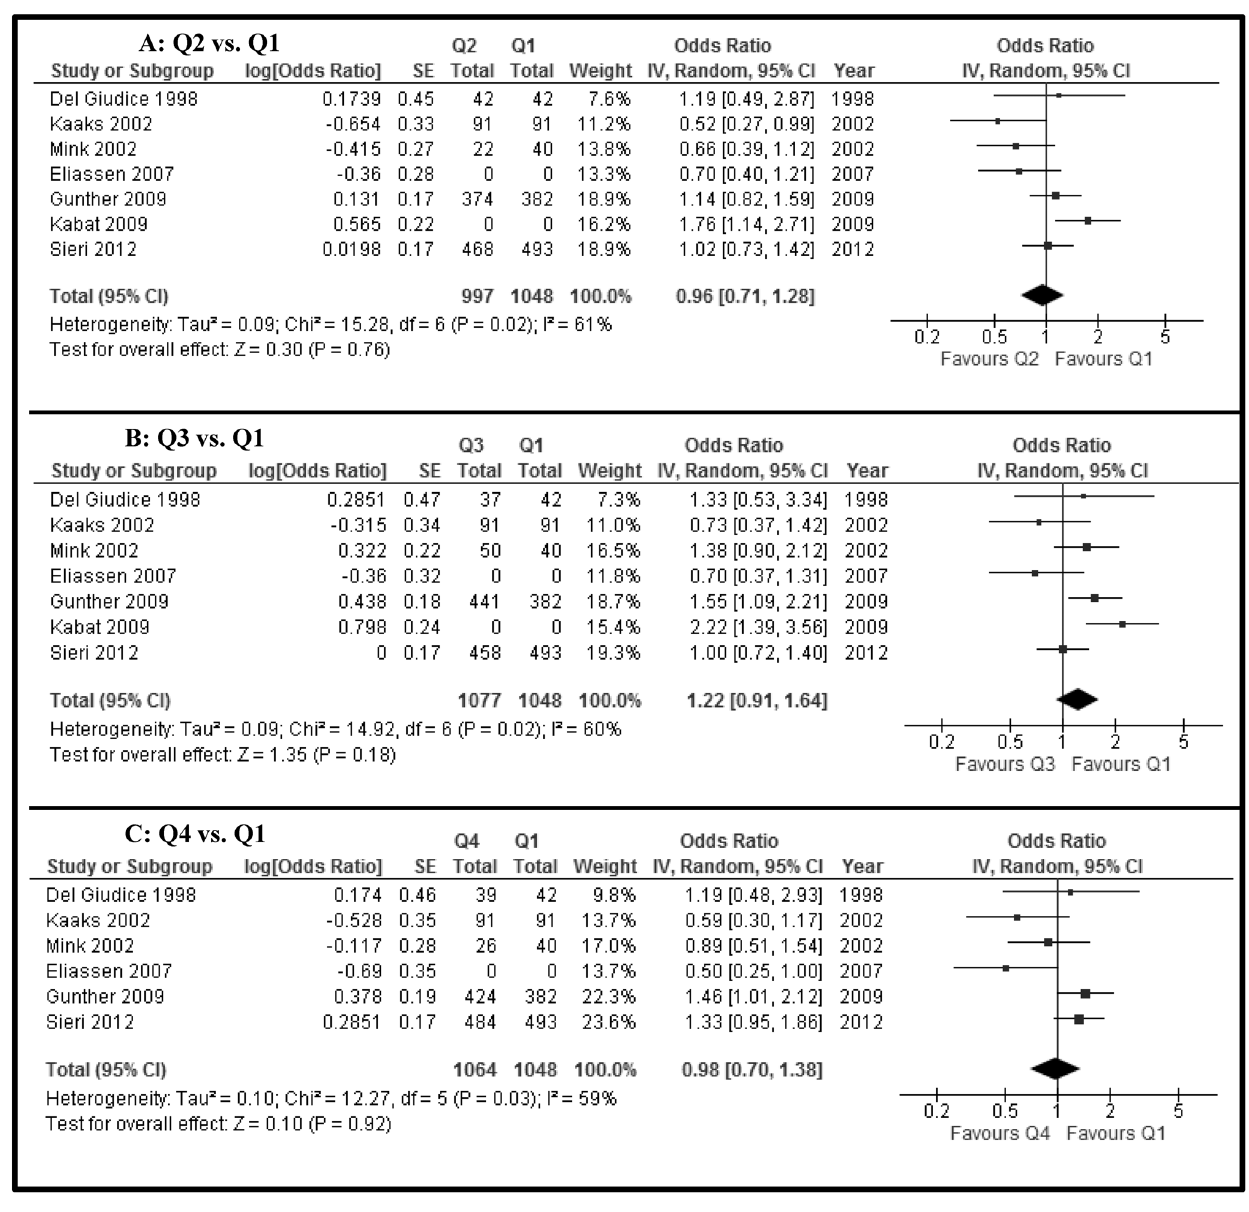
Figure 3. Forest plot of observational studies with adjusted ORs for breast cancer between quartiles of fasting insulin levels (A) Q2 versus Q1; (B) Q3 versus Q1; (C) Q4 versus Q1 ORs. (IV, Random= Inverse variance, Random effects model.) insulin or the area below the 3-hour insulin curve may be associated with breast cancer risk. Higher fasting insulin levels have been slightly associated with higher risk of endometrial cancer (OR highest quartile vs. lowest quartile of insulin 1.64, 95%CI 1.12–2.40) [44].